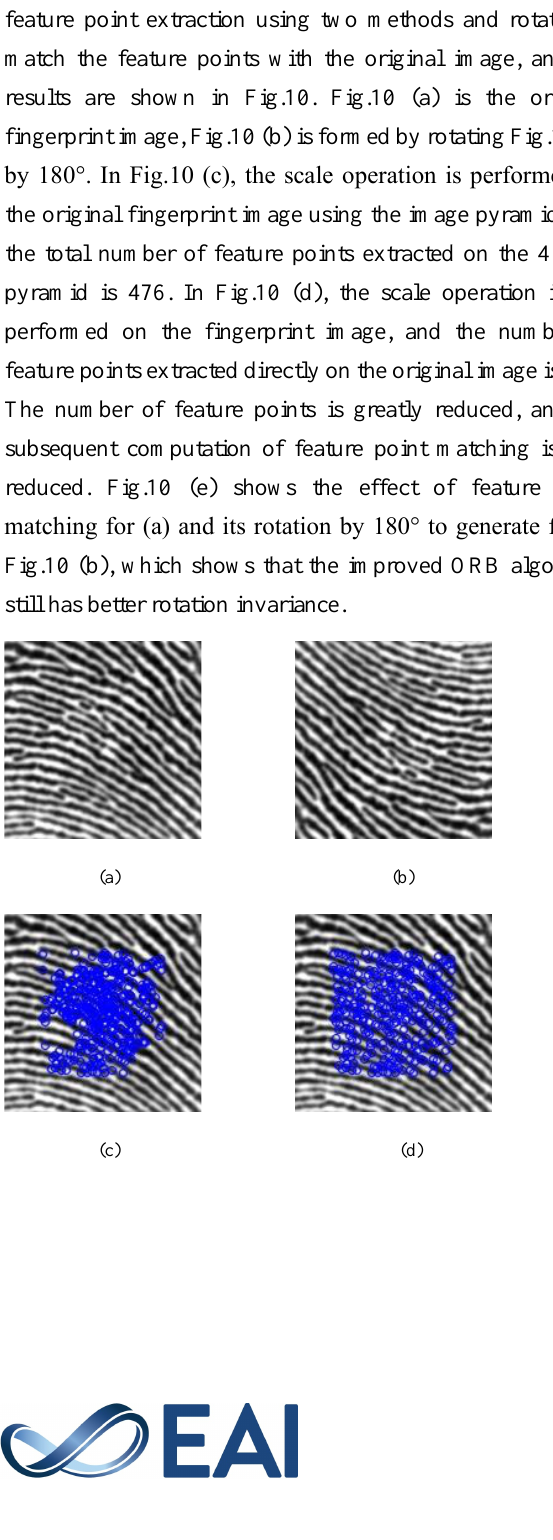
Figure 10. Feature point extraction and matching effect. (a) Fingerprint image a. (b) (a) rotated by 180°.(c) ORB extracts the feature points in (a). (d) Improved ORB to extract feature points in (a). (e) Improved ORB algorithm rotation change matching